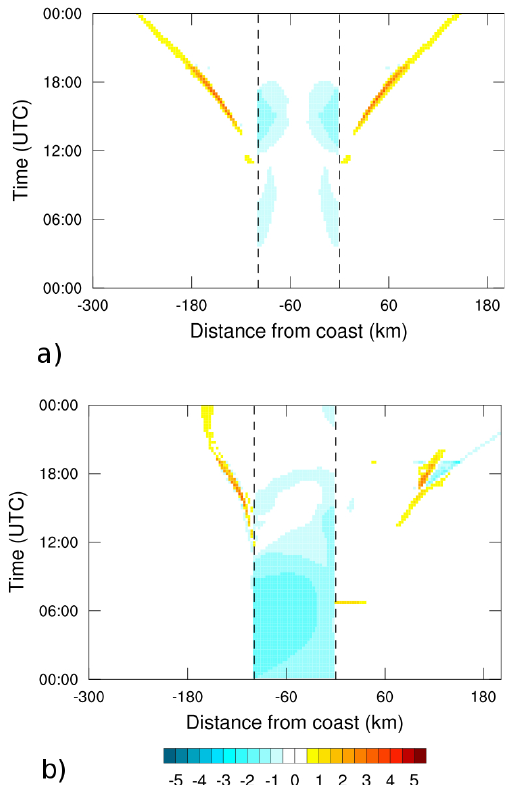
Fig. 23. Differences in 10m u-wind component for (a) the baseline case and for (b) 4ms − 1 . In each figure, the differences represent a simulation with sea surface skin temperature of 290K subtracted from a 280K simulation. In all cases, the YSU PBL was